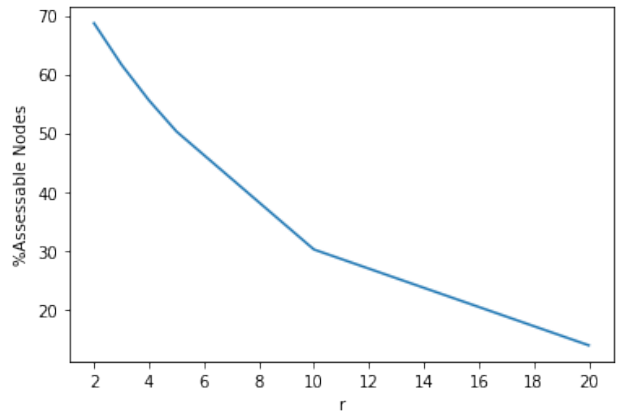
Figure 9. The percentage of assessable nodes for different values of r